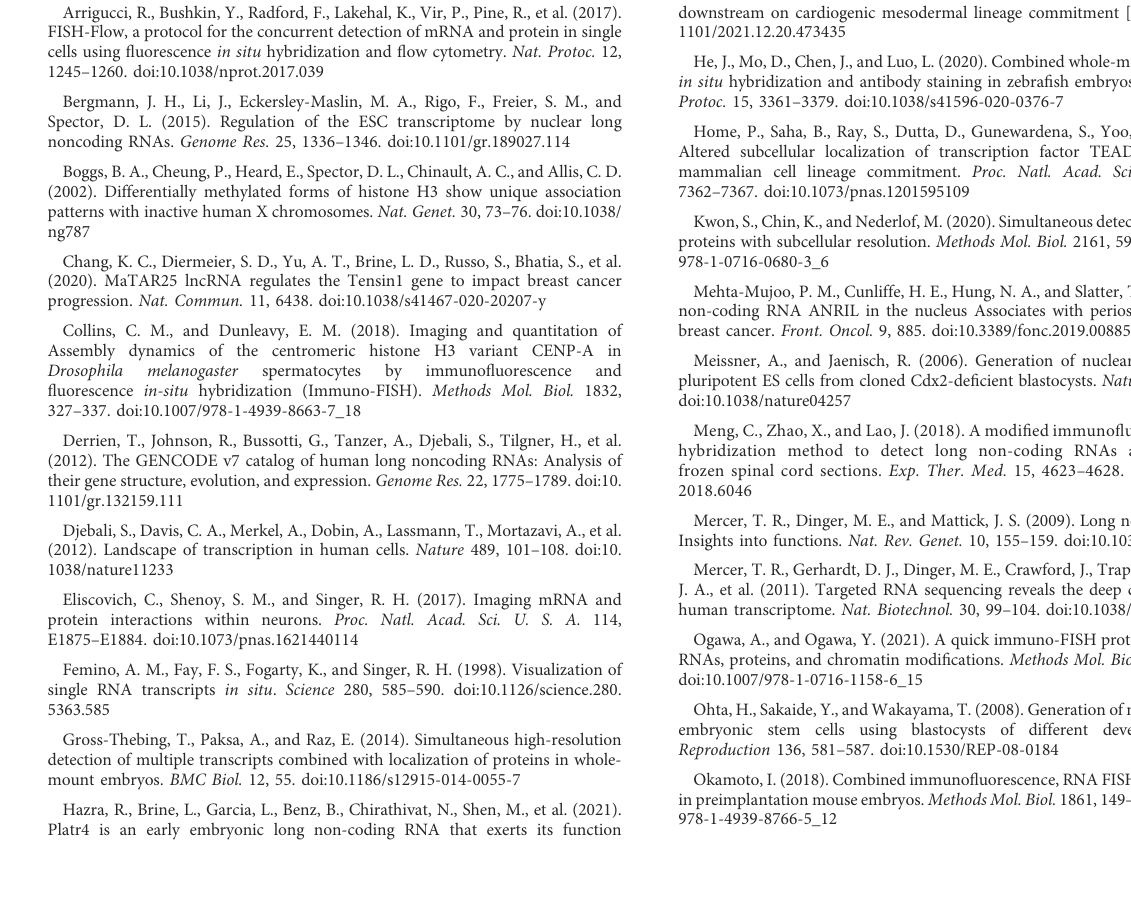
SUPPLEMENTARY FIGURE S1 Bright Field images of live mouse blastocysts before fi xing in PFA. Scale bar: 100 μ m. SUPPLEMENTARY FIGURE S2 (A) Combining IF and smRNA FISH using a Malat1 lncRNA probe and anti- Cdx2 antibody (B) Combining IF and smRNA FISH using a Platr4 lncRNA probe and anti-Tead4 antibody.Nuclei were counterstained with DAPI. Mouse anti-Cdx2 and mouse anti-Tead4 primary and Alexa Fluor 488- conjugated goat anti-mouse secondary antibodies were used for IF detection. The green color represents either Cdx2 or Tead4 IF signals, and red punctate dots for smRNA FISH signals of Platr4 or Malat1. All images are shownas maximum intensity Z- projection, scale bar:12 μ m. SUPPLEMENTARY FIGURE S3 Visualization of Polr2a and Pou5f1 mRNAs in combination with Tead4 IF signal. Mouse anti-Tead4 primary and Alexa Fluor 488-conjugated goat anti-mousesecondaryantibodieswereusedforIFdetection.Thegreen color represents Tead4 IF signals, and red and cyan punctate dots for smRNA FISH signals of Polr2a and Pou5f1. All images are shown as maximum intensity Z-projection, scale bar: 12 μ